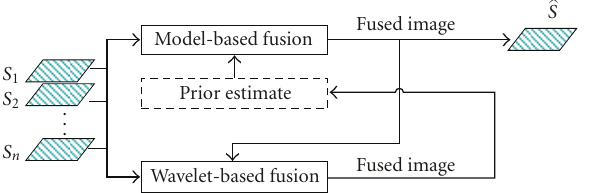
Figure 9: Framework of wavelet and model-based fusion by multi- single turbo iterative.